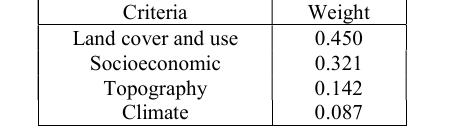
Table 6. Criteria weights for fire risk map